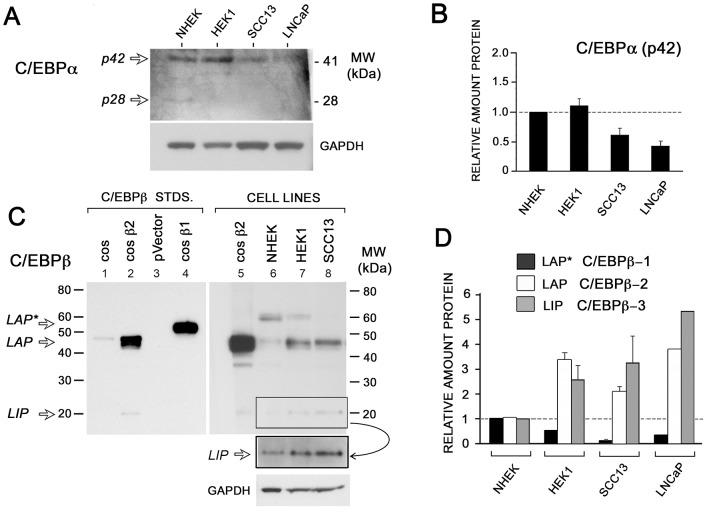
C/EBPα and C/EBPβ isoforms are differentially expressed in SCC cell lines as compared to normal human keratinocytes.Western analyses of normal primary keratinocytes (NHEK), and two squamous cell carcinoma cell lines, HEK1 and SCC13. (A) Western blot for C/EBPα, in the skin cell lines and also in prostate carcinoma cells (LNCAP). GAPDH is a loading control. (B) Densitometric quantification for C/EBPα. (C) Western blots for C/EBPβ. Lanes 2 and 5 (cos β2) contain recombinant human cDNA for C/EBPβ overexpressed in cos-7 cells, which translate only LAP and LIP. Lane 4 (cos β1) contains recombinant human T7 his-tagged C/EBPβ-1 plasmid expressed in cos-7 cells. Lanes 1 and 3, extracts from cos-7 cell that were untransfected or transfected with the empty vector (pVector), respectively. Box, longer exposure of C/EBPβ-3. GAPDH, loading control. (D) Densitometric quantification of each isoform of C/EBPβ. Graphs represent the average of two independent Western analyses, with protein levels normalized to GAPDH and expressed relative to NHEK (dotted line).